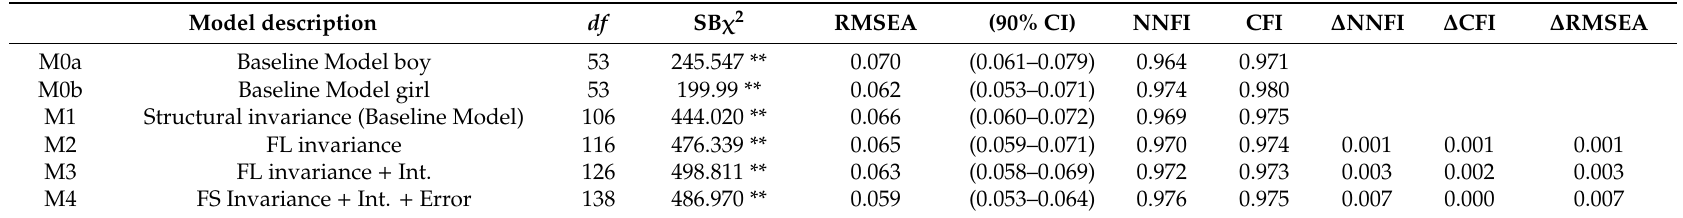
Table 2. Goodness-of-fit indexes of the invariance